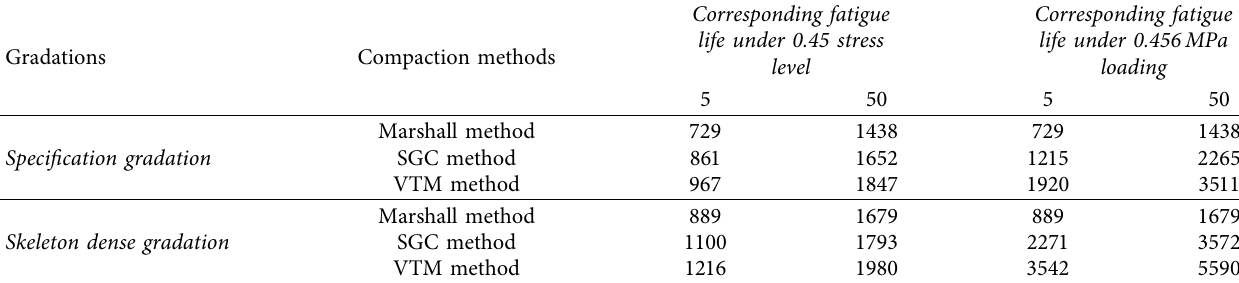
Table 12: Fatigue life of SMA-13 mixture with different compaction methods and gradations.